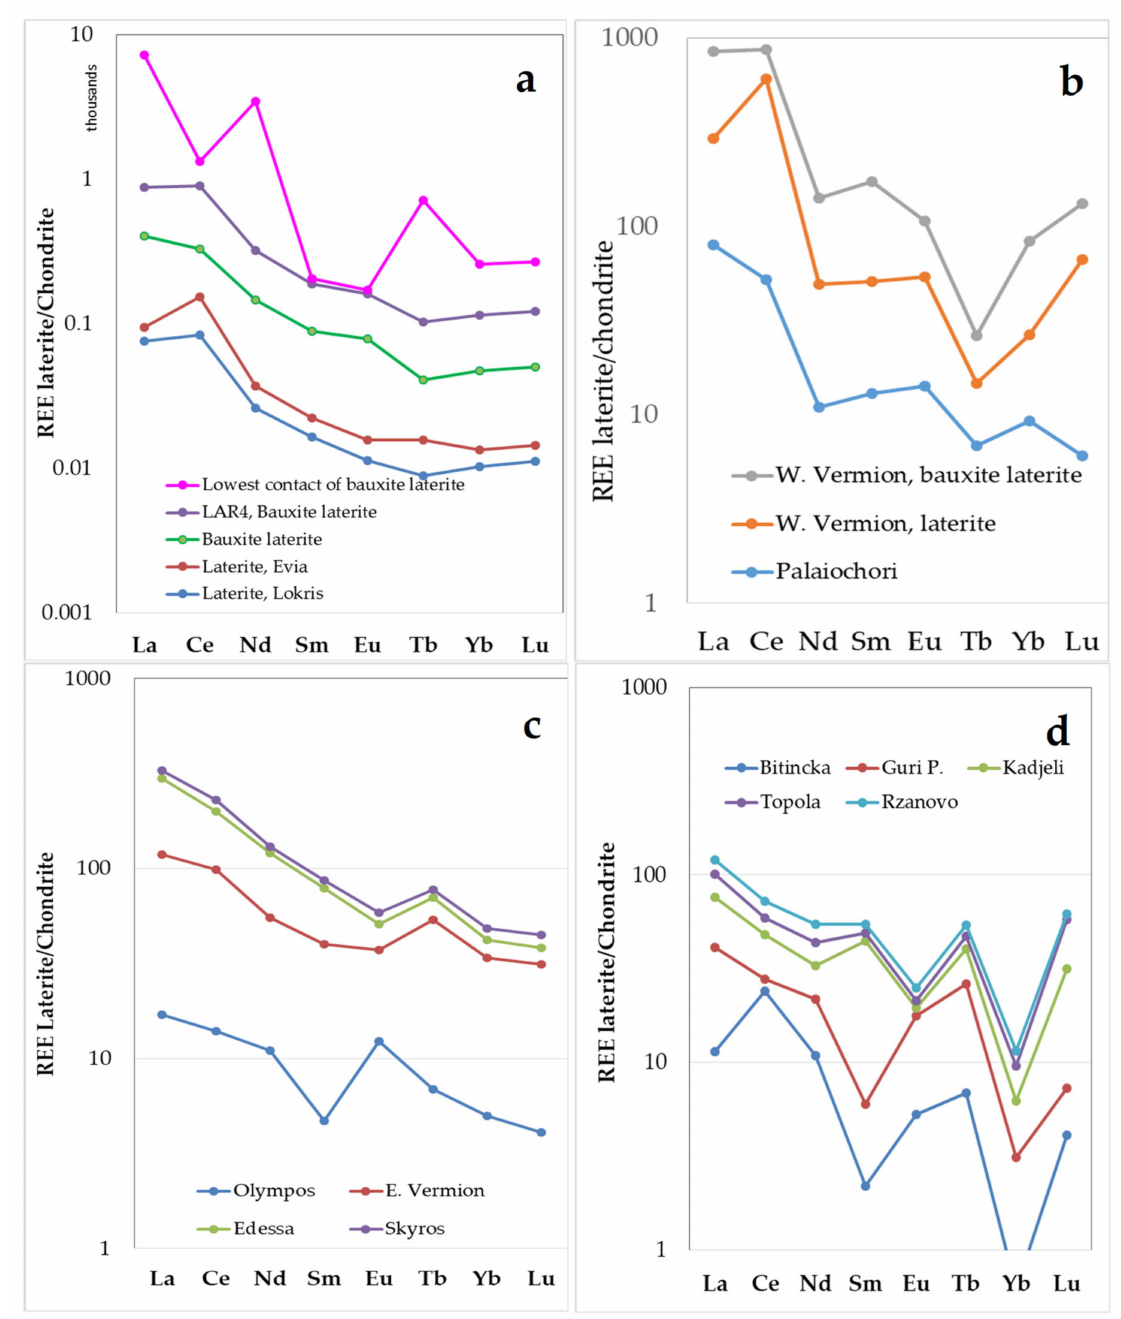
Figure 10. Chondrite normalized REE-patterns for average values of samples from Fe–Ni laterites and bauxite laterites, from the Lokris and Evia ( a ), Palaiochori and W. Vermion ( b ), Olympos, E. Vermion, Edessa, and Skyros ( c ) and Albania, Serbia and N. Macedonia (former F.Y.R.O.M.) ( d ). Data from Tables